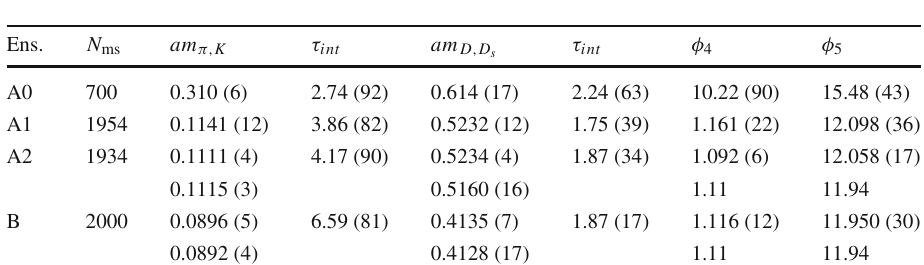
Table 4 Light meson masses and tuning results, the second row values for ensembles A2 and B are shifted to the correct tuning points φ 4 and φ 5 , using the strategy described in Sect.